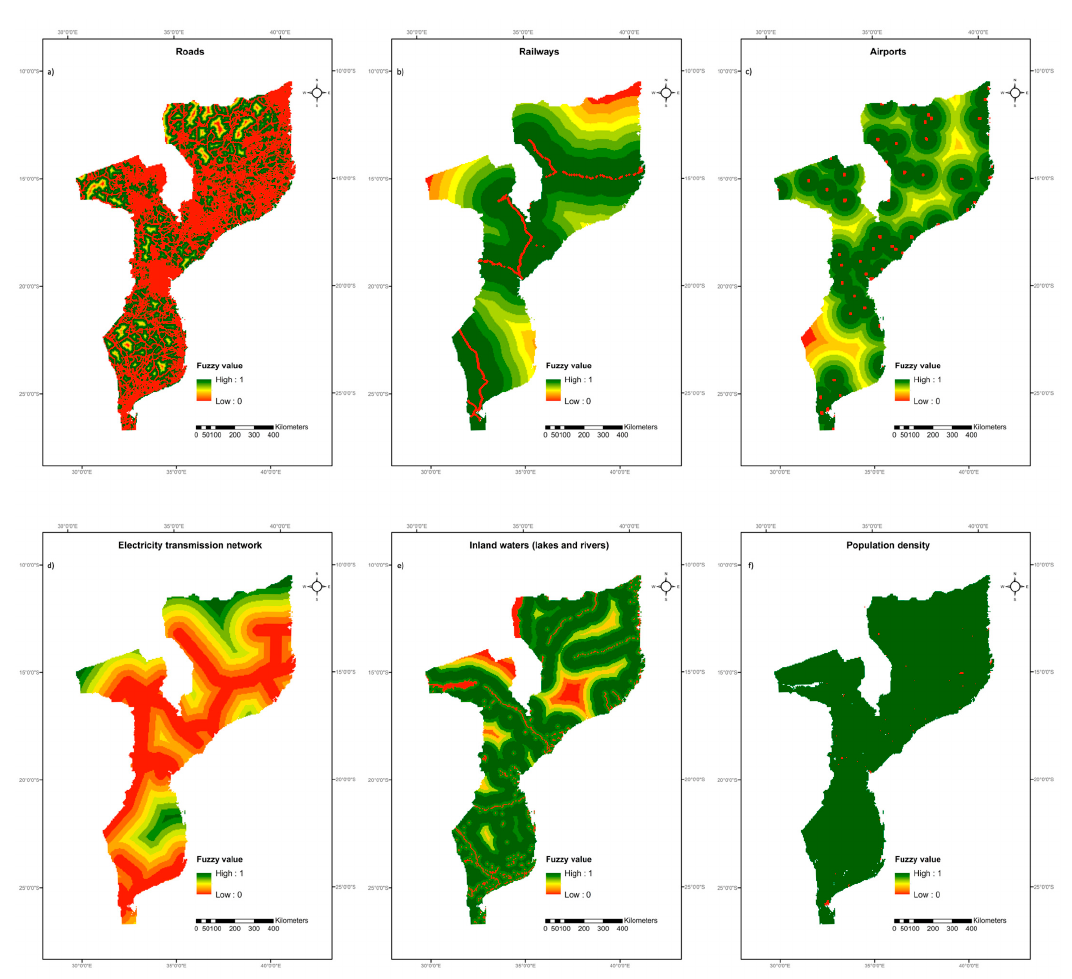
Figure A5. Standardized (reclassified and fuzzified) raster maps of technical-location criteria ap- plied to the spatial suitability of off-grid solar PV microgrid projects in Mozambique. ( a ) Distance from roads, ( b ) distance from railways, ( c ) distance from airports, ( d ) distance from the electricity transmission network, ( e ) distance from inland waters, and ( f ) areas of low population density.